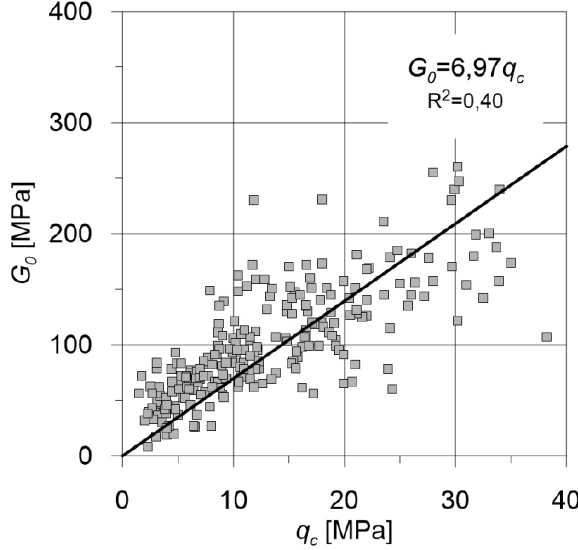
and cone resistance 0